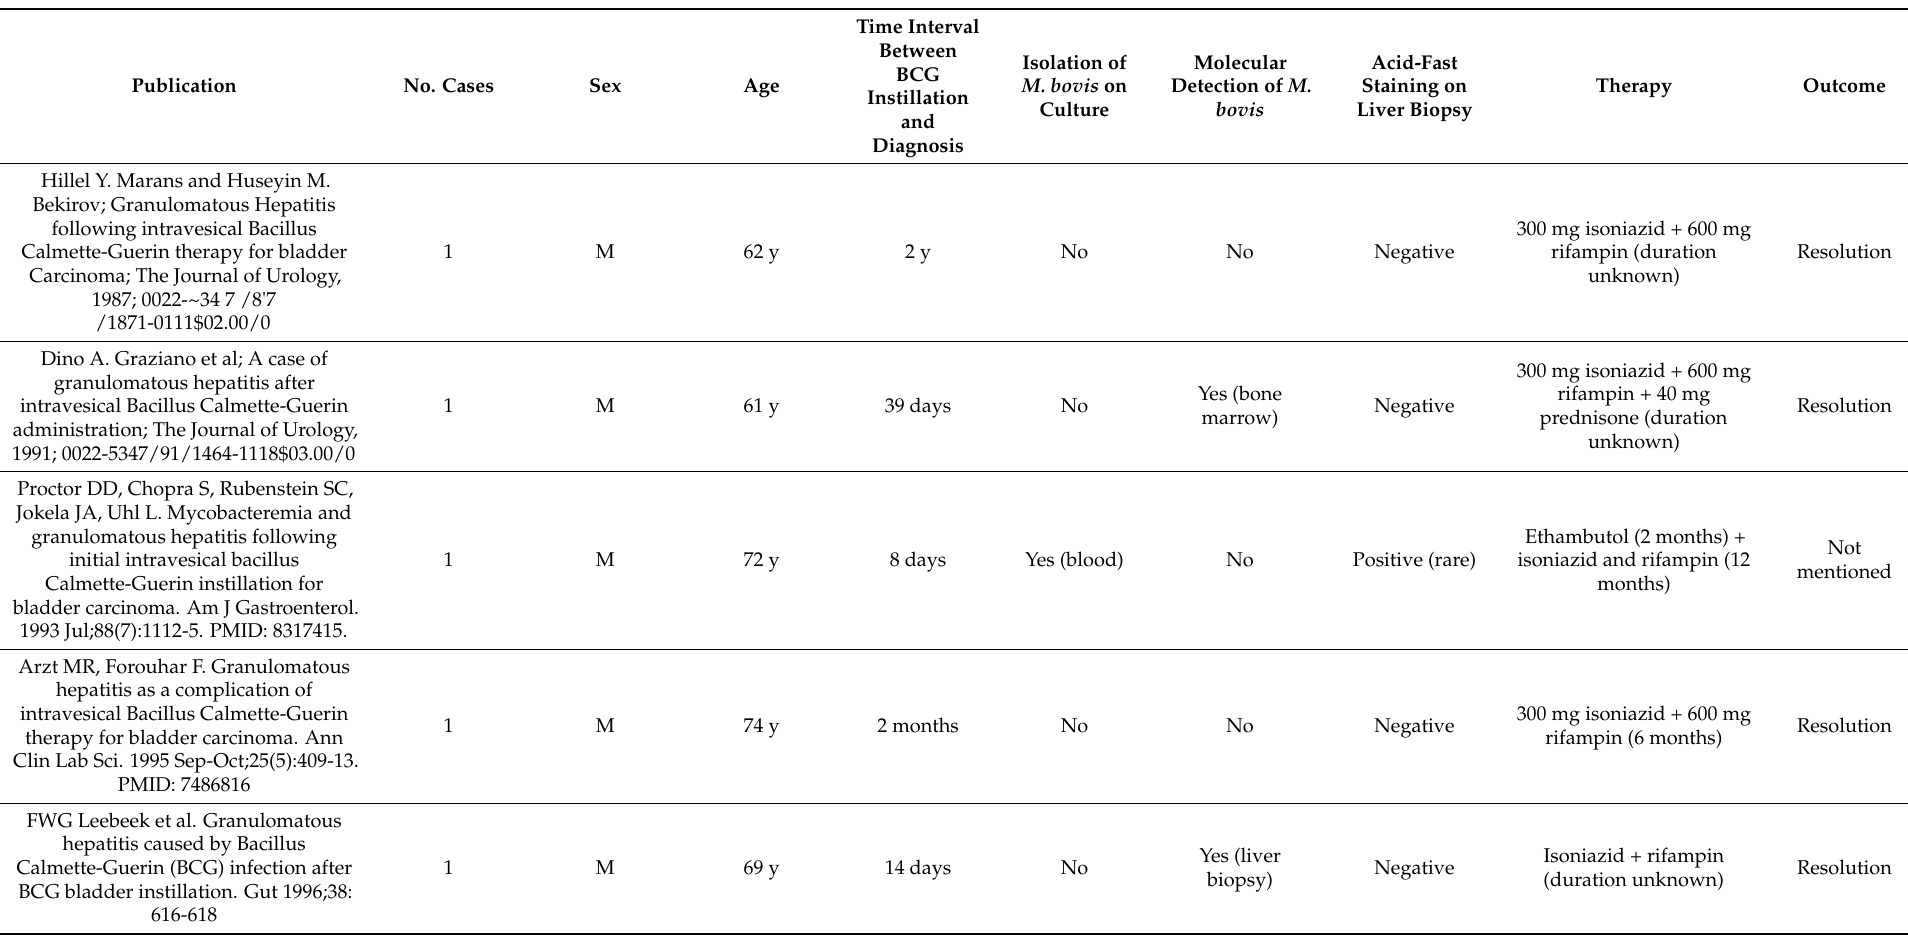
Table 1. Summary of some cases of granulomatous hepatitis following intra-vesical BCG therapy published in the